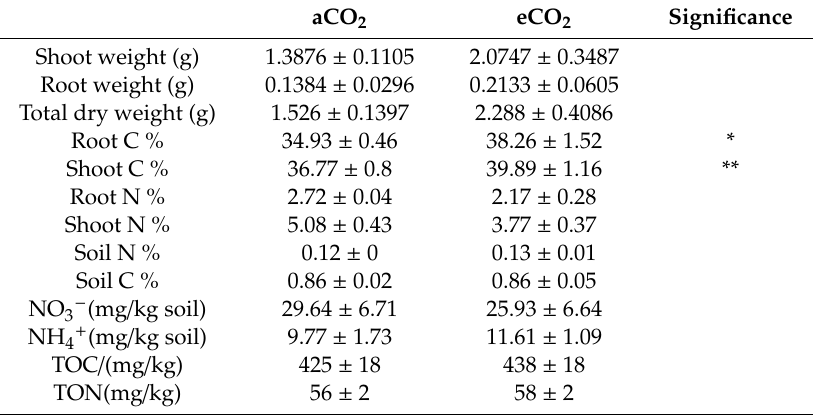
Table 1. E ff ects of eCO 2 on plant and soil characteristics and the significance was assessed by two tails-permutation T test or Wilcox